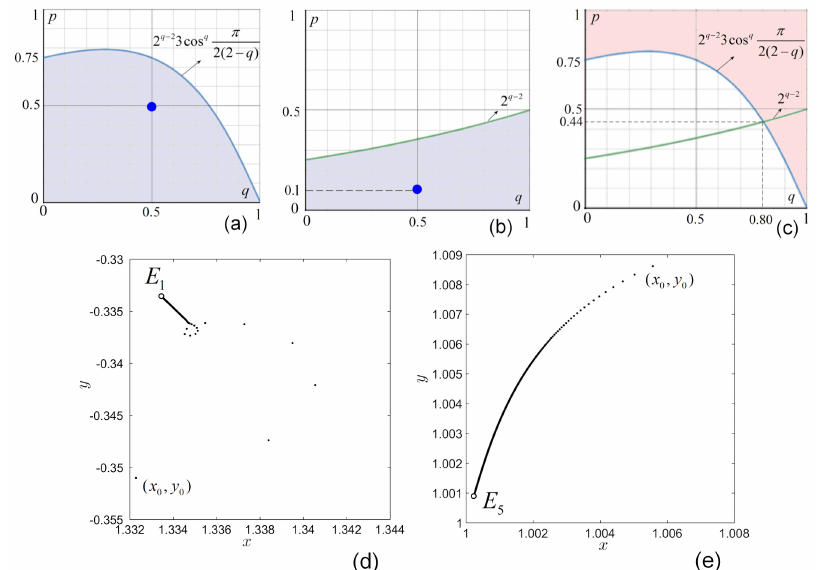
Figure 1. Stability regions of equilibria. ( a ) Stability region of E 1 (grey plot); ( b ) Stability region of E 5 (grey plot); ( c ) Instability region of all equilibria (light red plot); ( d ) Phase plot of a representative orbit from the point within the stability region of E 1 , with p = 0.5 and q = 0.5 (Figure 1a) from